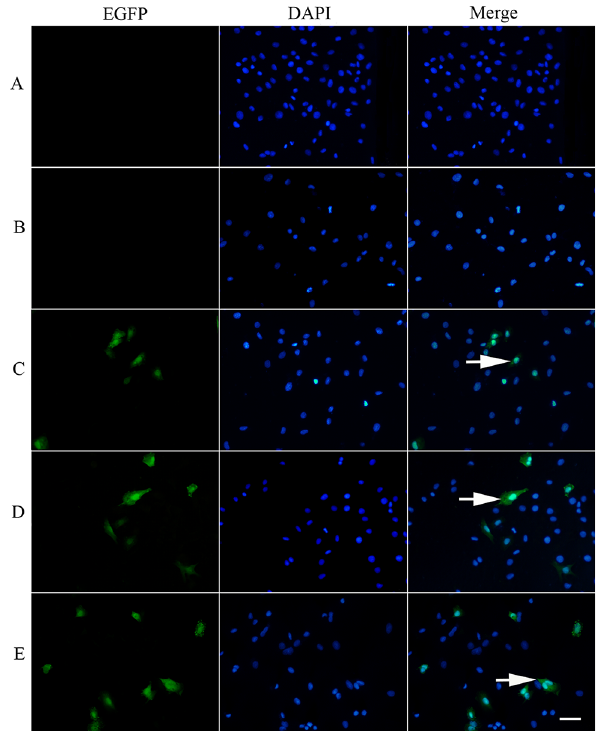
Fig 1. EGFP expression in H9C2 Cells of Group A-E at 48 h post-transfection (200×). (A): untreated group; (B): treated with pEGFP-N plasmid DNA; (C): treated with PEI/DNA complexes; (D): treated with PEI/ DNA complexes with ultrasonic exposure; (E): treated with PEI/DNA complexes plus PFPMS with ultrasonic exposure.